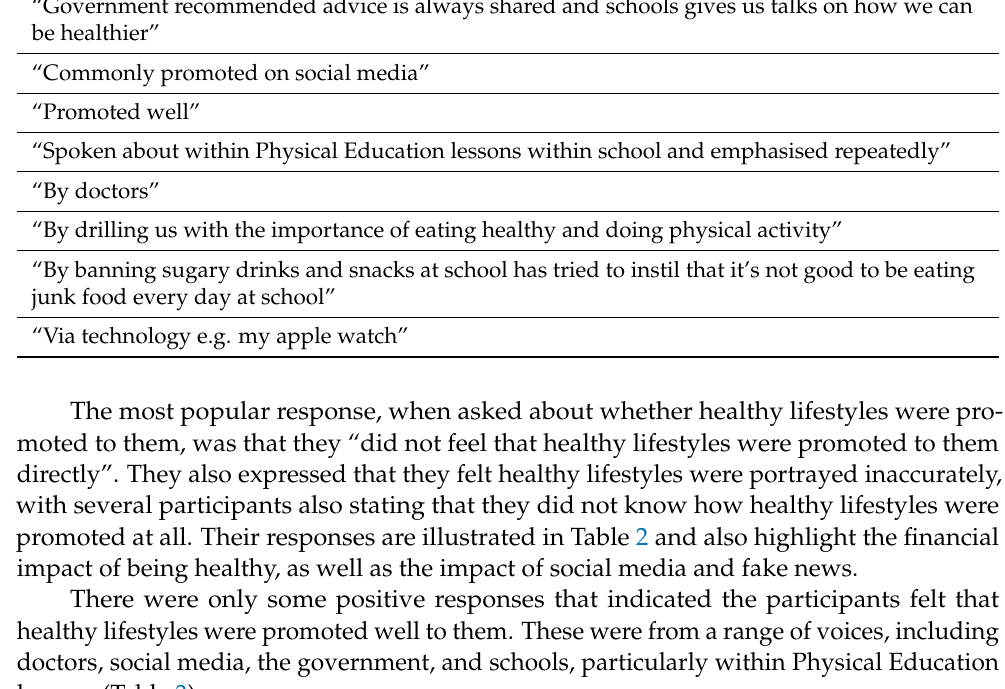
Table 3. Positive responses to healthy lifestyle